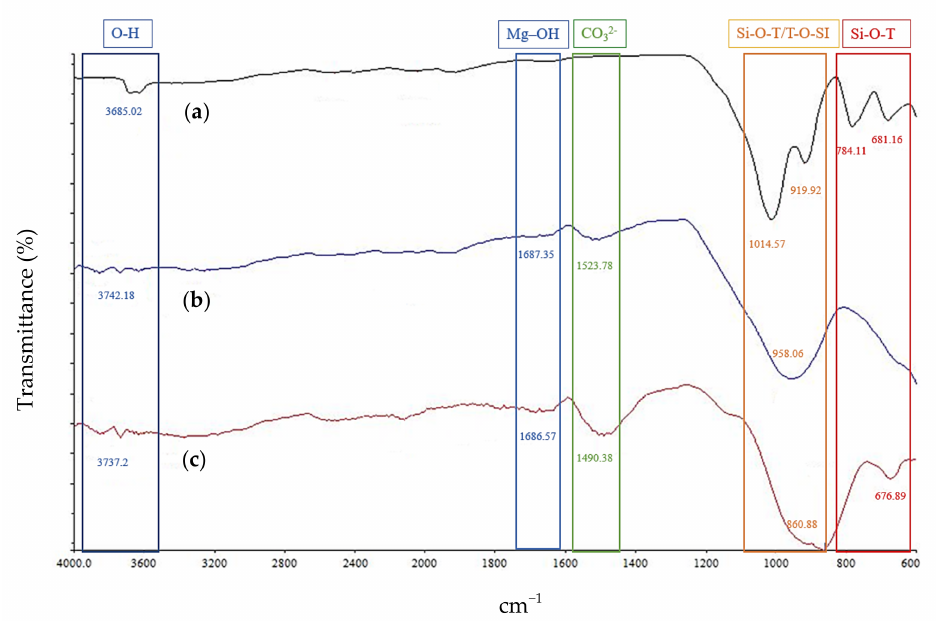
Figure 2. FTIR spectra of ( a ) soil, ( b ) fly ash, and ( c )